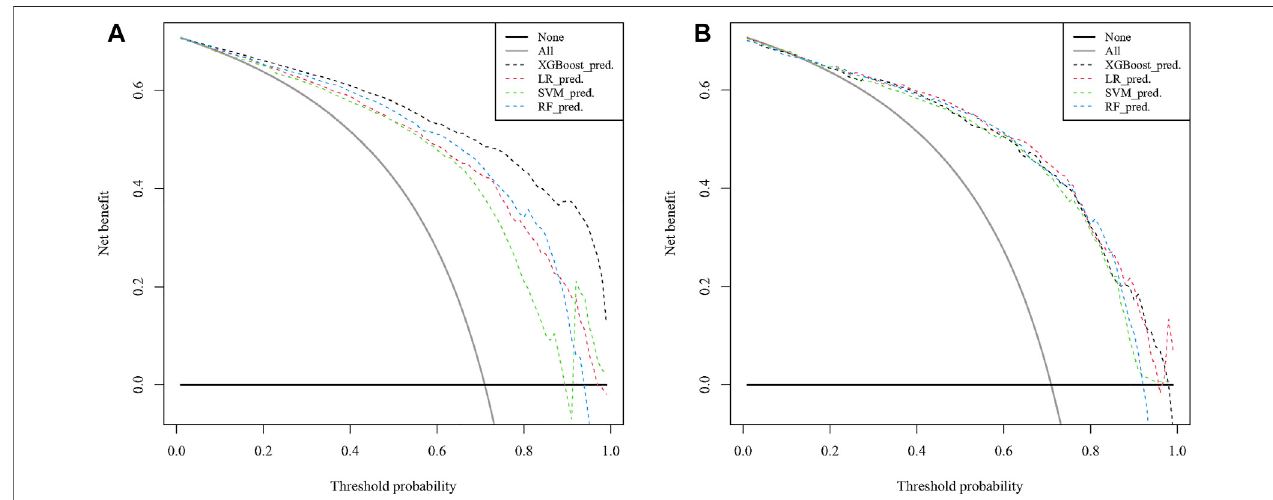
FIGURE 6 | Decision curve analysis to predict 10-years DTC development with DM in the training (A) and test (B) cohorts. DTC: differentiated thyroid cancer, DM: distant metastasis, XGB: XGBoost, SVM: support vector machines, RF: random forest, LR: logistic regression.